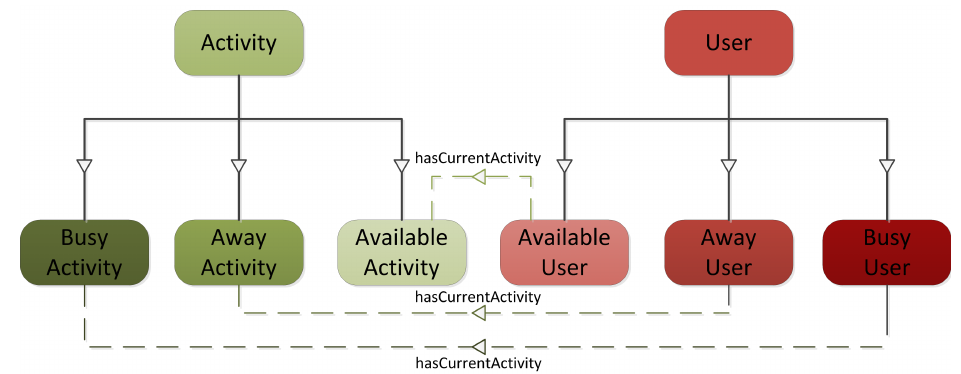
Figure 4. Users and Activities